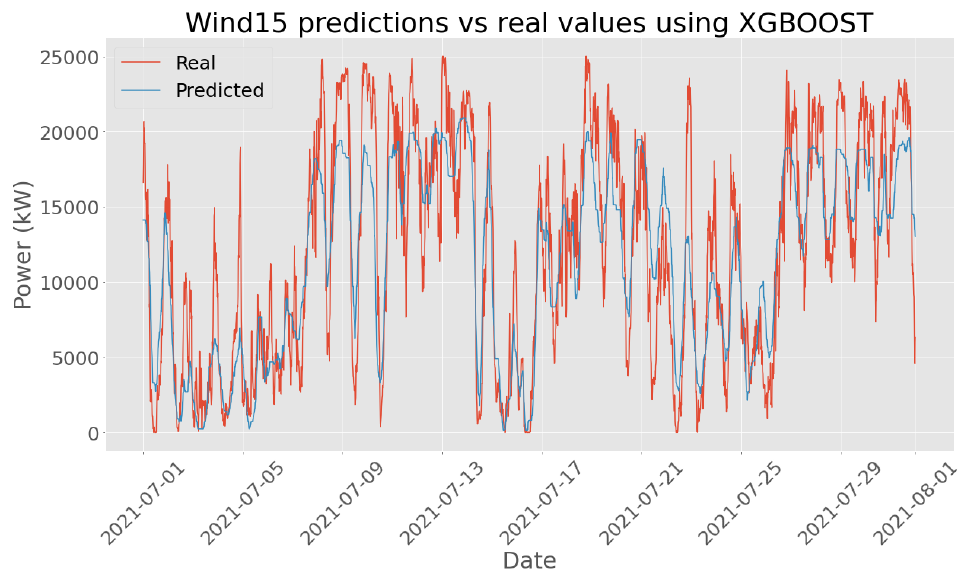
Figure 6. Forecast vs. real values plot for 6 months training, 1-month forecast using